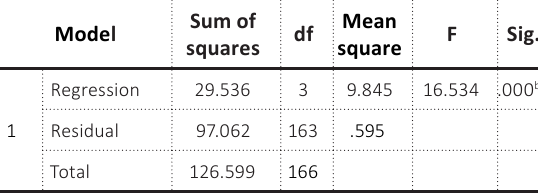
Table 4. Model fit results, ANOVA a (leadership styles and work engagement)